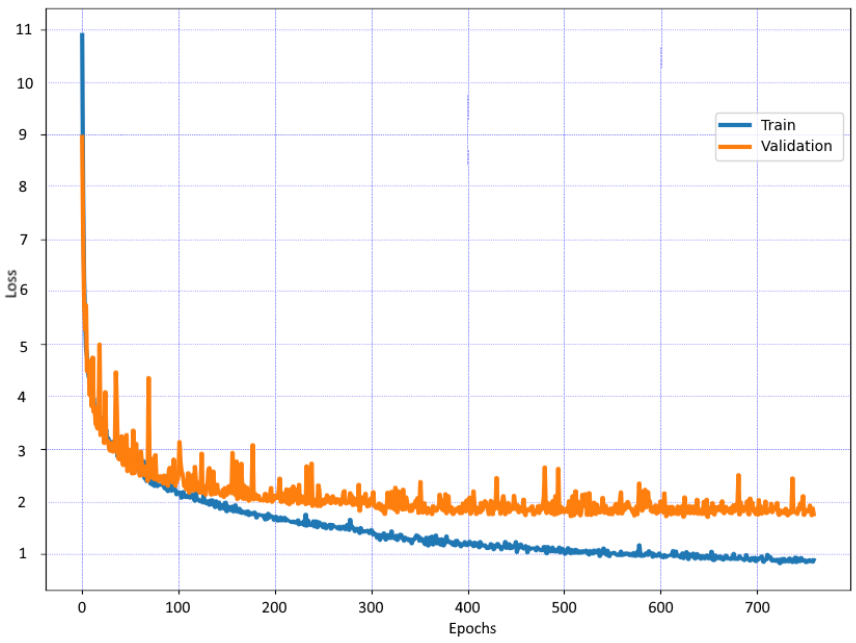
Figure 7. Loss function graph.